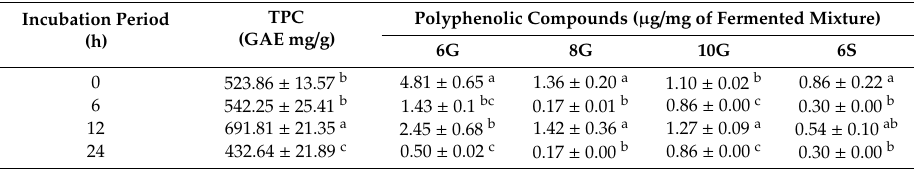
Table 2. Total polyphenolic content (TPC) and major polyphenolic compounds of digested ginger extract (GE) under simulated fermentation. All data are expressed as the mean ± SEM. Statistical analysis was performed using ANOVA.